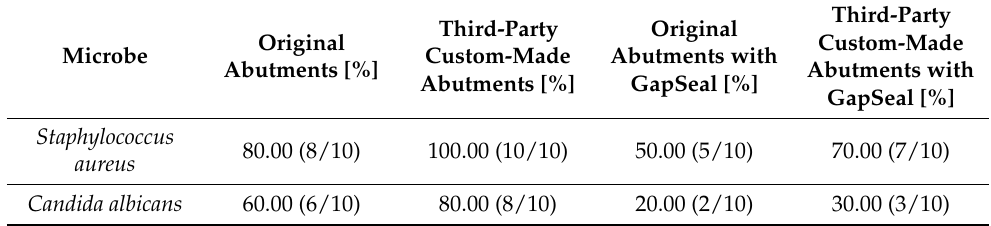
Table 1. The frequencies of bacterial and fungal microleakage (Zimmer Tapered Screw-Vent implants).